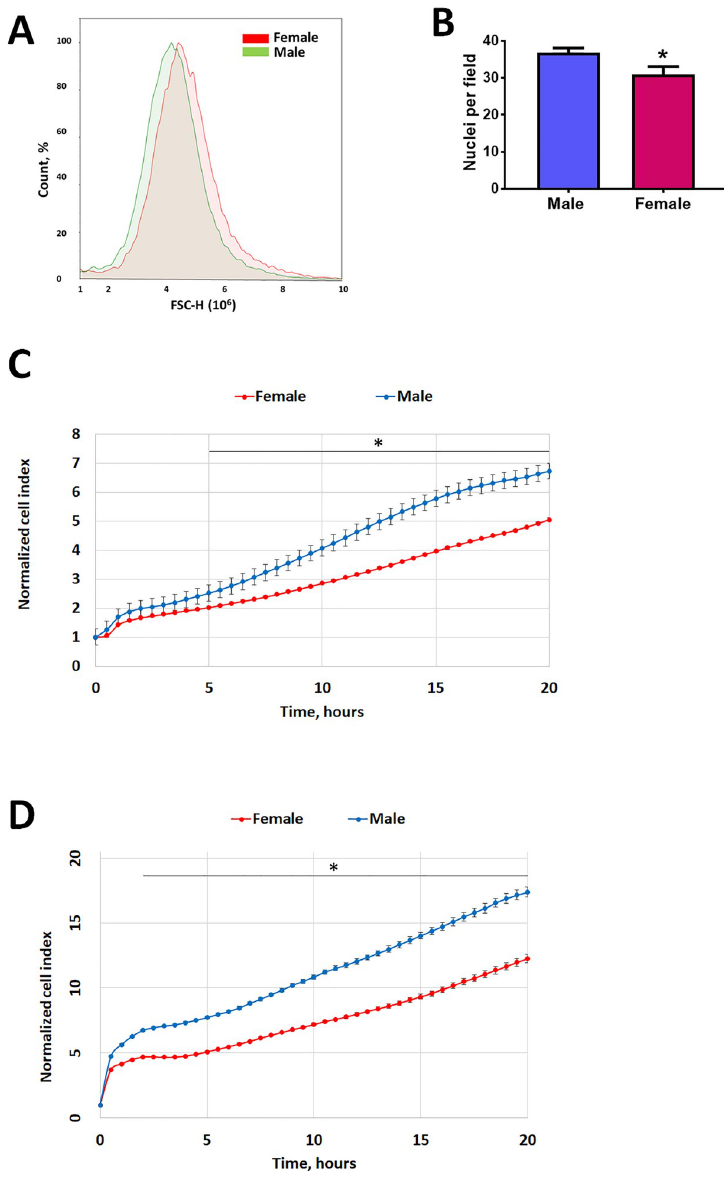
Fig 2. Sex difference in the endothelial size and proliferation rate. MLEC isolated from male mice were found to be smaller ( A, B ) and show a significantly higher proliferation rate ( C ) compared to female MLEC. A –representative forward scatter representing MLEC size, N = 5–7. B –number of nuclei per field of confluent MLEC at magnification 40X. The higher number of nuclei per field in male MLEC corresponds to the smaller size, N = 8 random fields per sex. Proliferation rate of MLEC ( C ) and HPAEC ( D ) measured using the iCELLigence System. For MLEC, values are means ± SEM; N = 6 repetitions from 5–7 mice isolated for each sex. For HPAEC, one out of two independent experiments is shown, N = 4 repetitions for each sex. � p < 0.05 versus female cells. Statistical analysis was performed using the unpaired